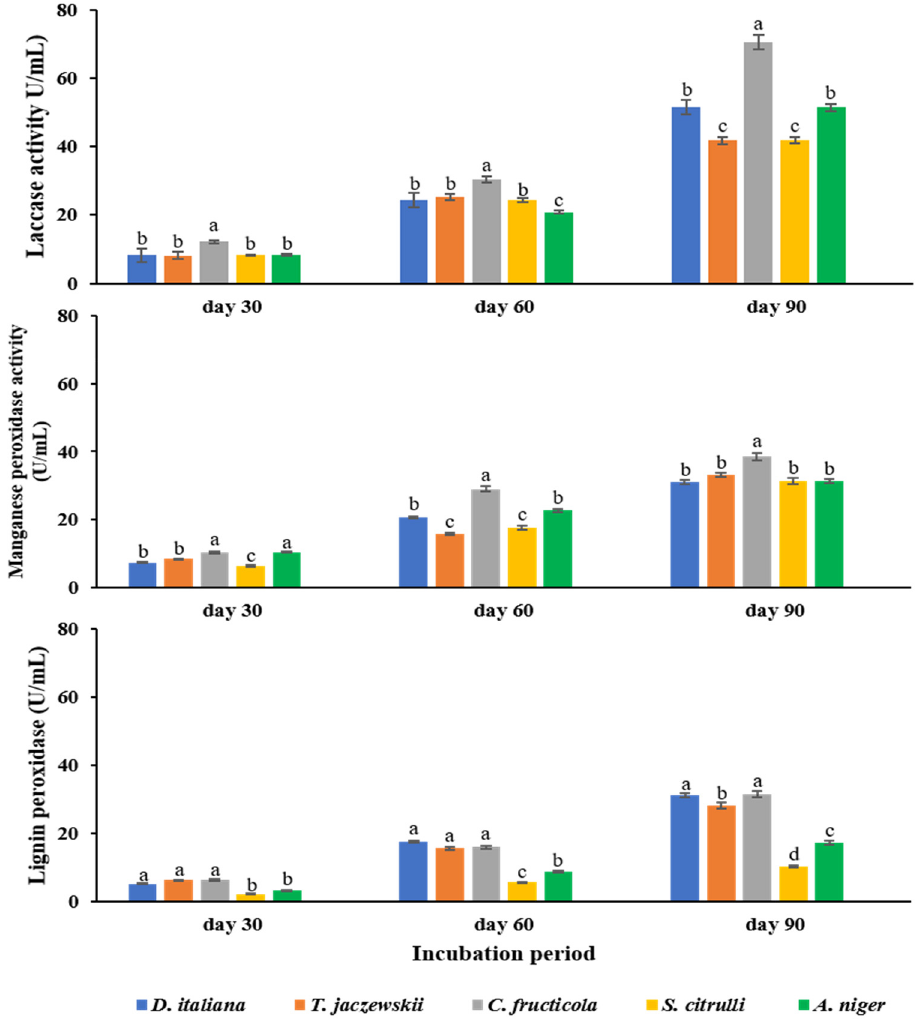
Figure 2. Enzymic activity in D. italiana , T. jaczewskii , C. fructicola , S. citrulli , and A. niger culture supernatant after 30, 60, and 90 days of incubation. Different letters above the bars indicate significant differences ( p < 0.05).